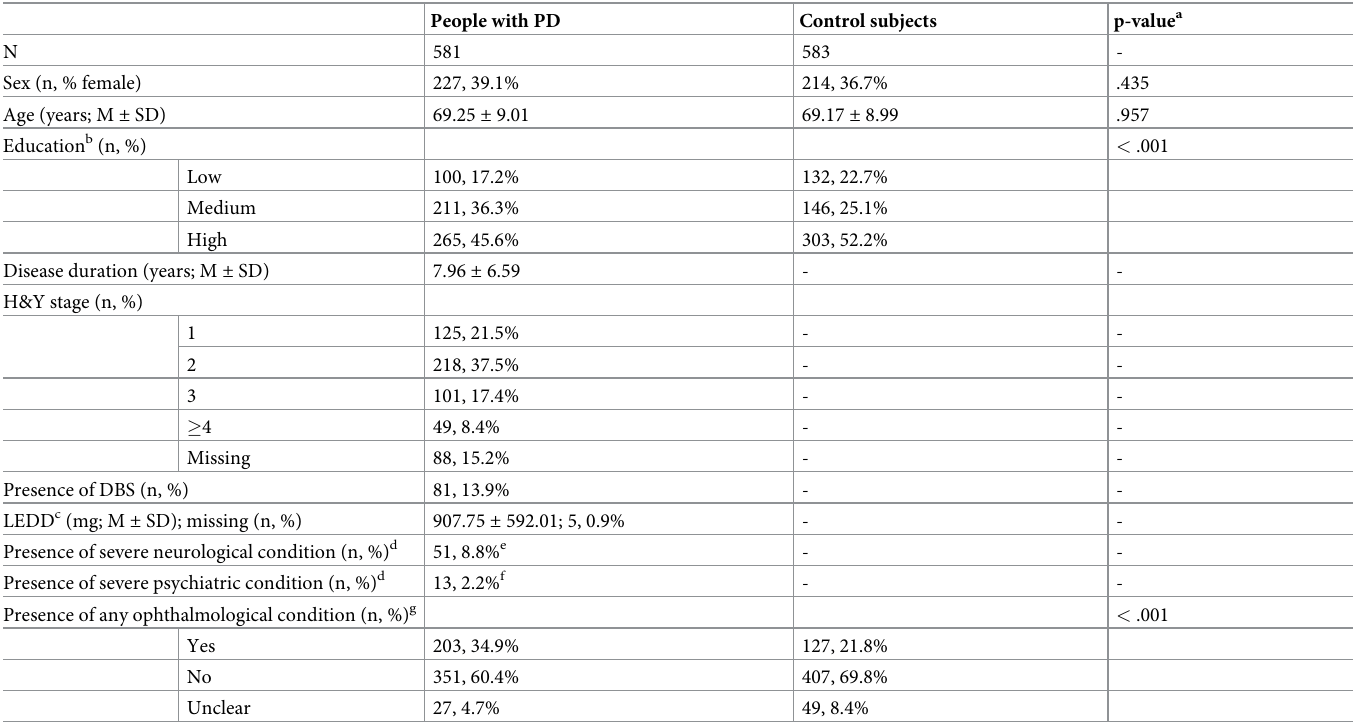
Table 1. Demographics and disease characteristics of people with PD and age-matched